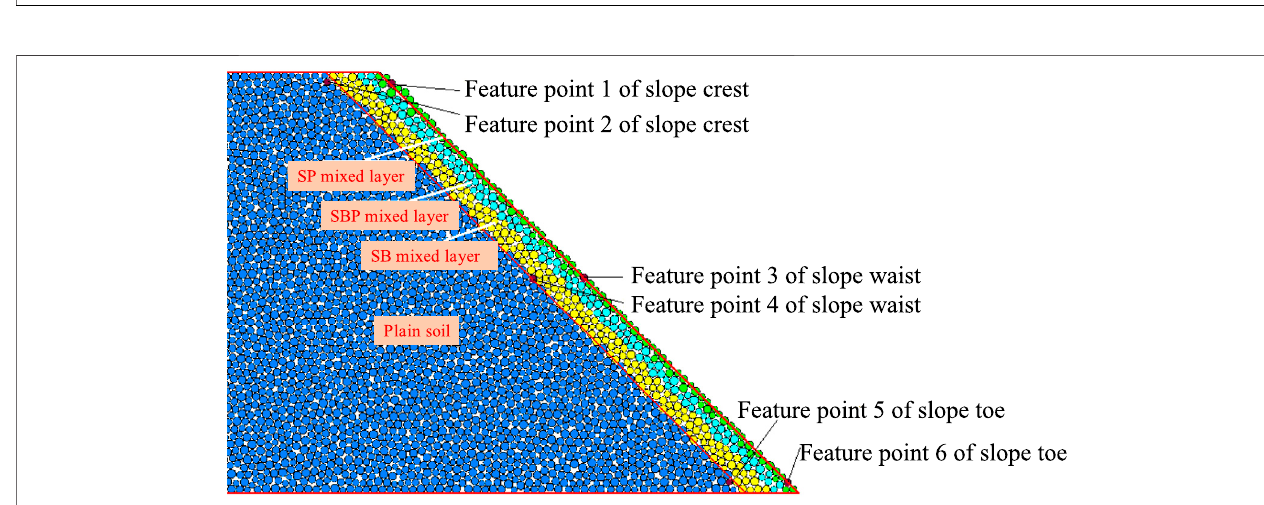
FIGURE 13 | Schematic diagram of the feature point locations